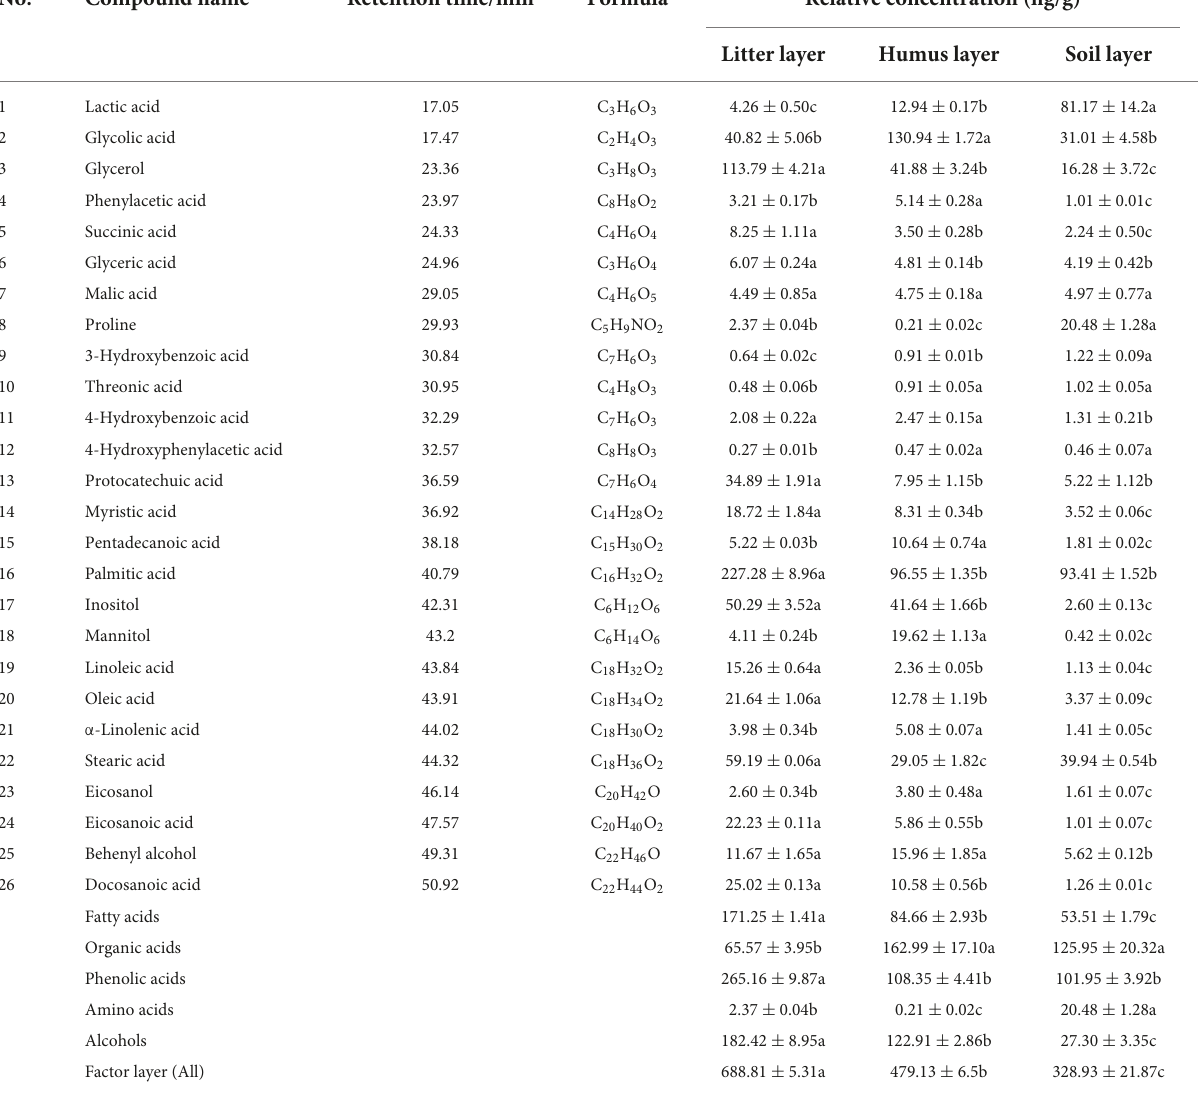
TABLE 2 The primary allelochemicals in the three